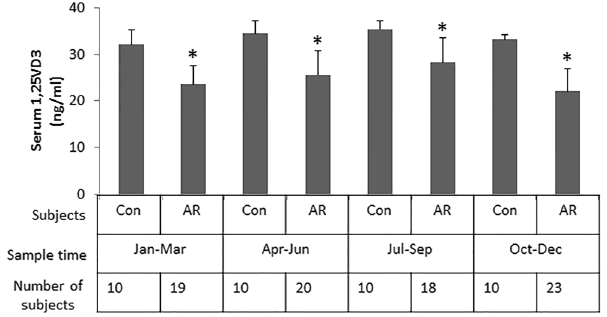
Figure 1. Assessment of serum 25VD3. The bars indicate the serum levels of 25VD3 in healthy subjects (Con) and AR patients, which were recruited in different seasons. * p < 0.01, compared with the control